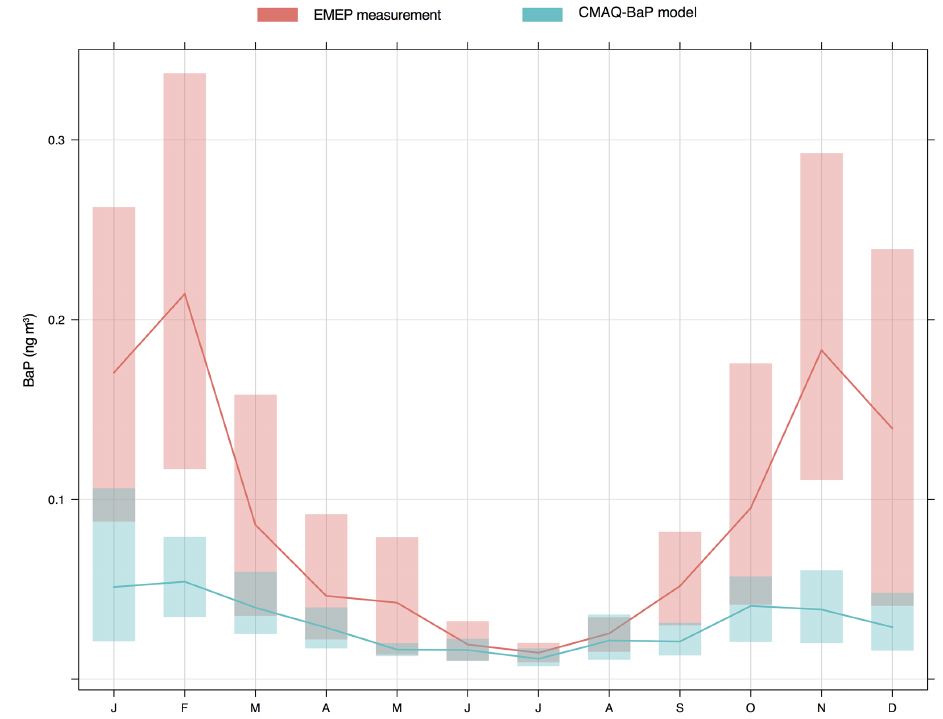
Figure 8. Model predicted and observed monthly BaP concentrations (ngm − 3 ) across all EMEP sites in 2006 for the dual GPP model scenario